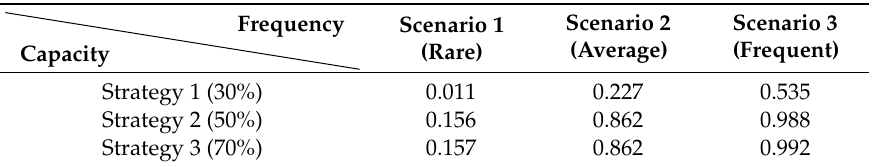
Table 3. Uncertainty determined for strategies